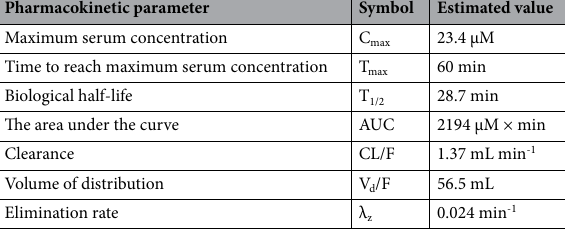
Table 1. Pharmacokinetic parameters of PZ-DHA in Balb/c female